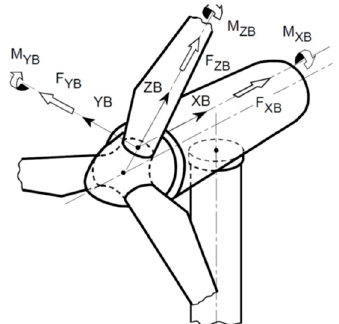
Figure 1. Blade Coordinate System [15].